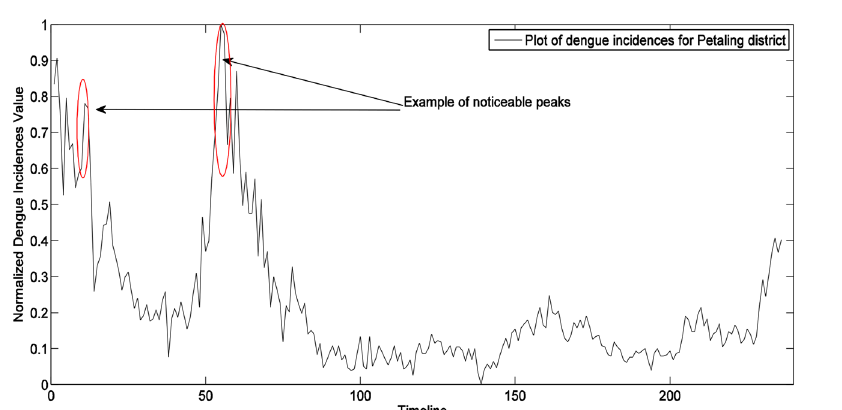
Figure 3. Plot dengue cases for Petaling district.